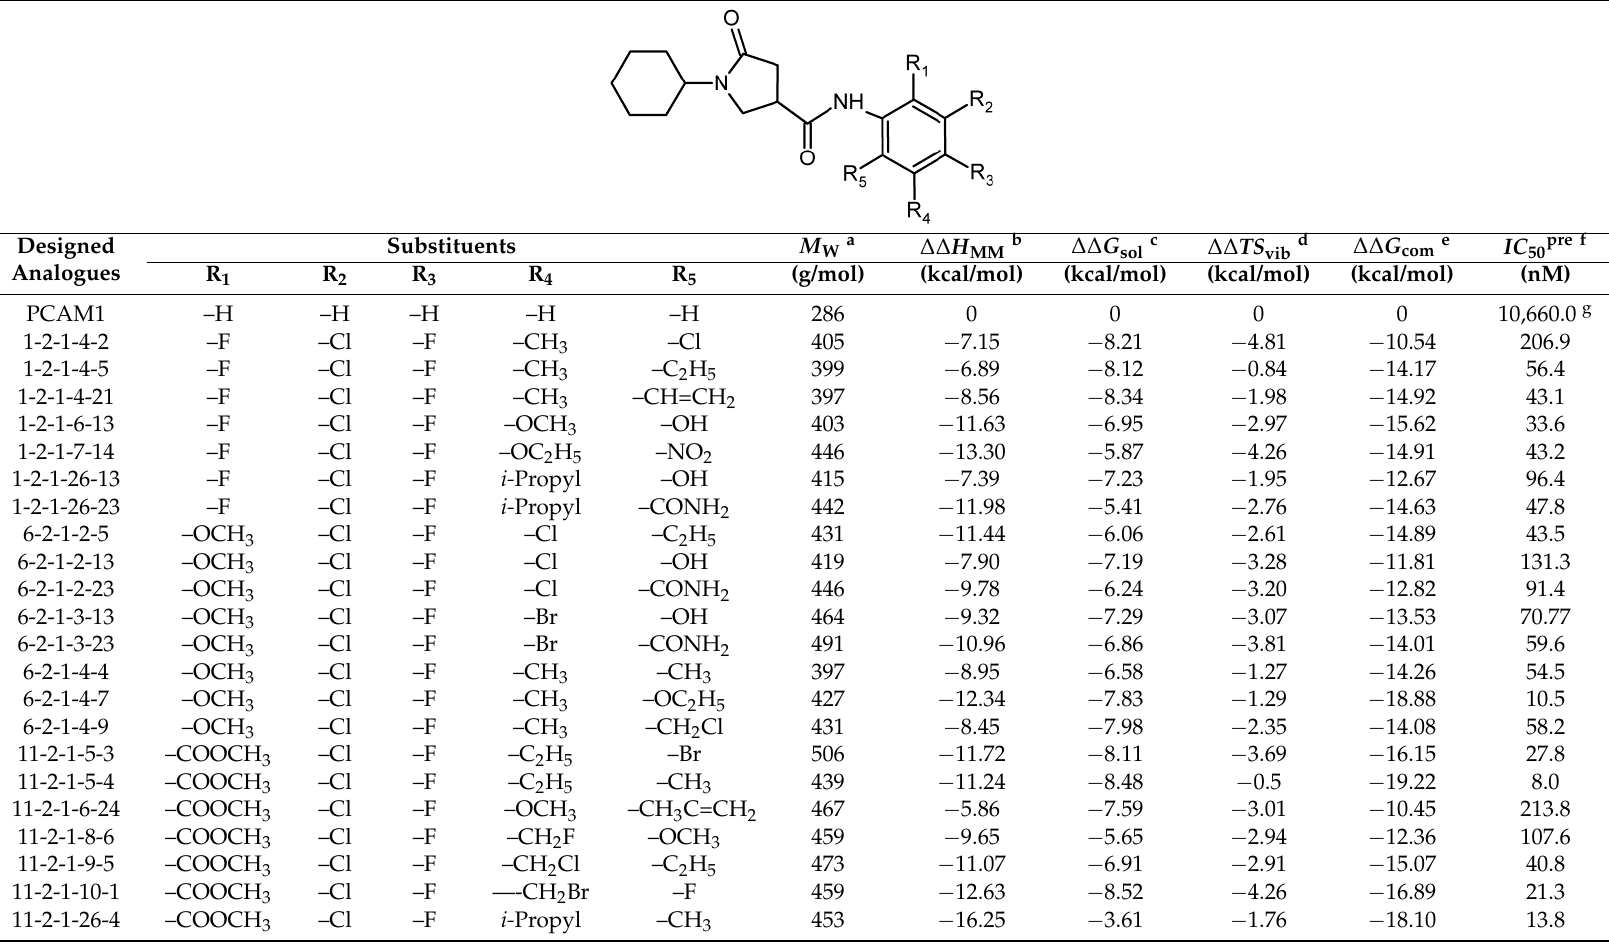
Table 6. Complexation Gibbs free energies and their components for the top 100 scoring virtually designed PCAM analogues. The analogue numbering concatenates the index of each substituent R 1 to R 5 with the substituent numbers taken from Table 5 except for hydrogen which is directly specified by the letter H.